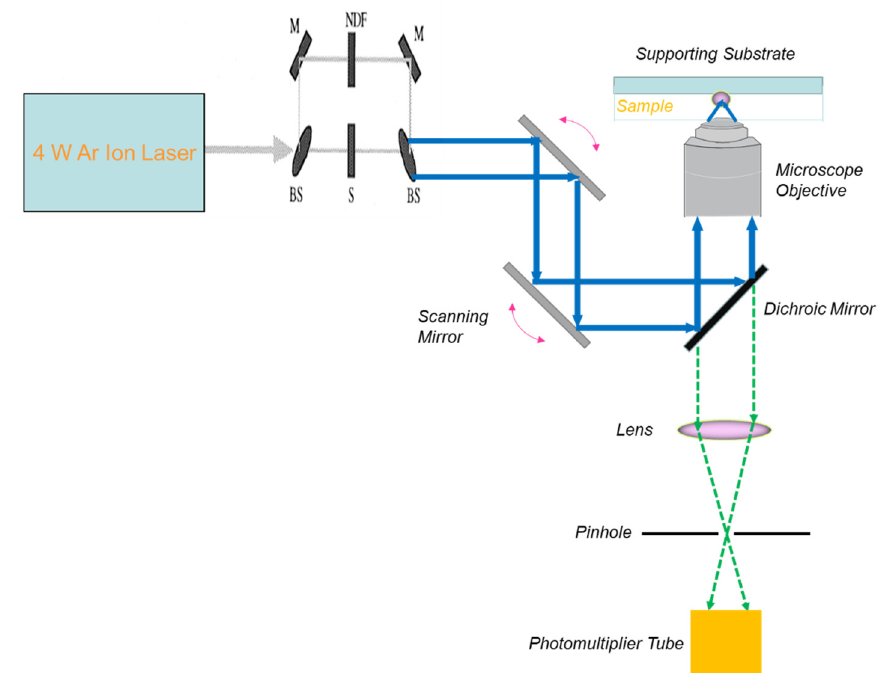
Figure 7. The overall optical train for the Confocal FRAP setup. Beam Splitter: BS; Aperture: A; Prism: P; Shutter: S; Neutral Density Filler: NDF.